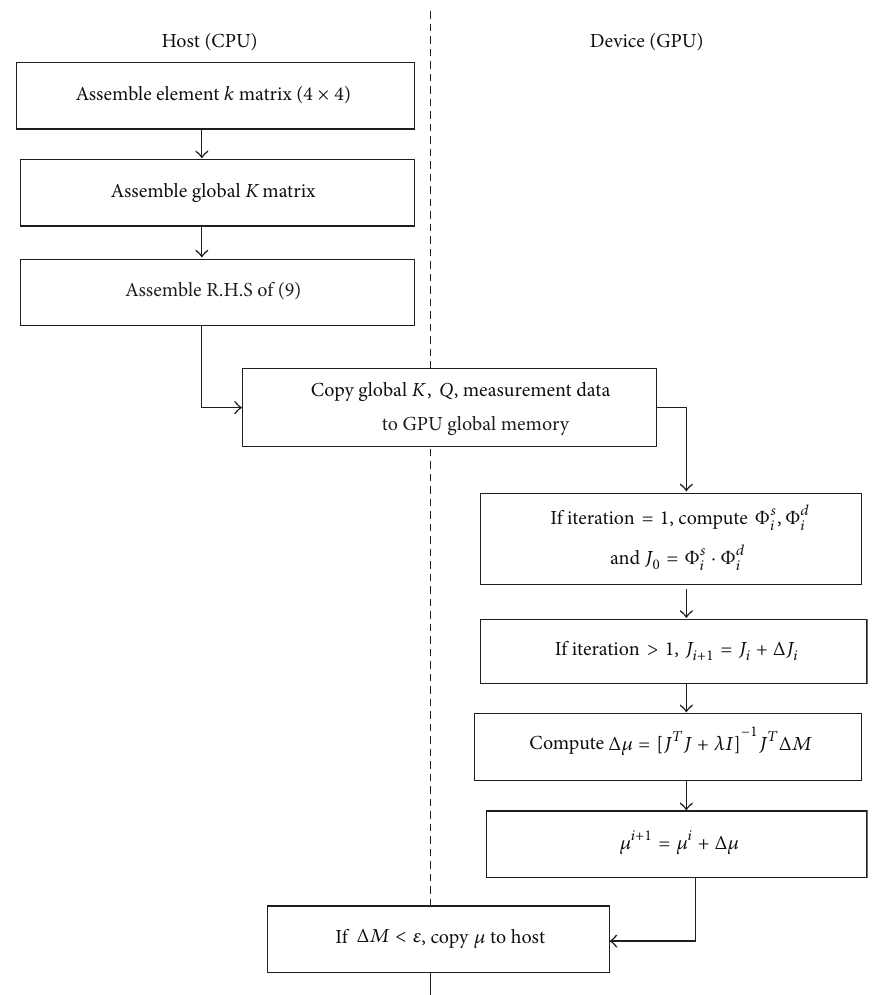
Figure 3: Data flow between the host CPU and GPU